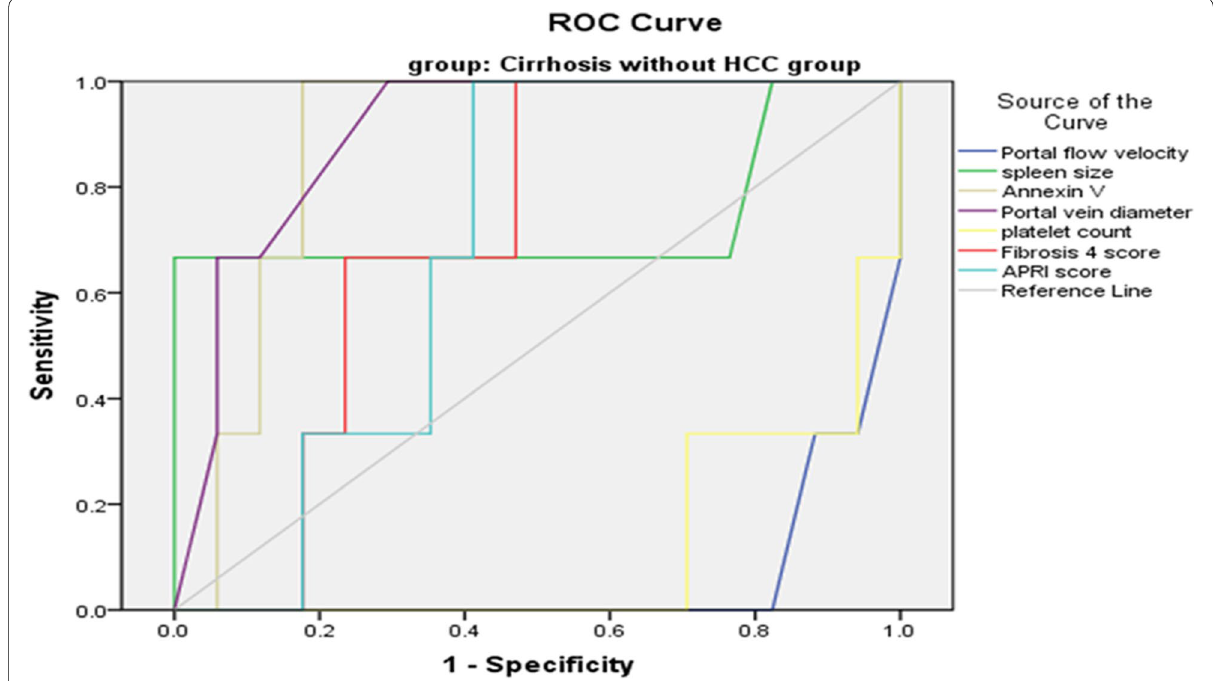
Fig. 2 ROC for the group of cirrhosis without